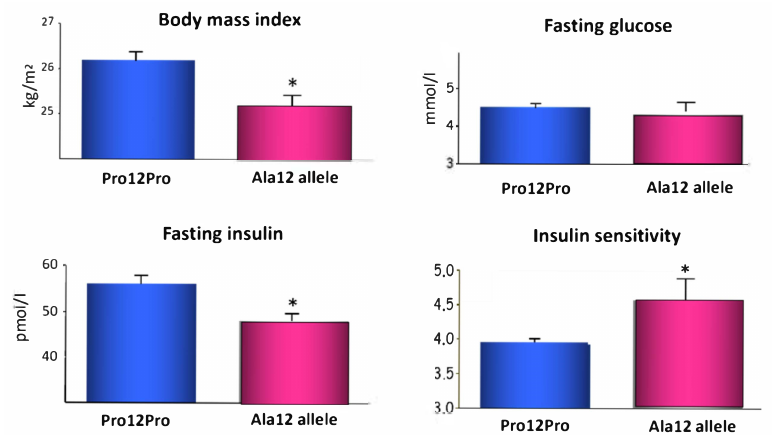
Figure 2. Body mass index and fasting insulin were significantly decreased and insulin sensitivity was increased (* p < 0.05) in the carriers of the Ala12 allele of PPARG2 . Altshuler et al. [19] performed a meta-analysis of 16 separate studies including over 3000 participants, and showed that the Pro allele of PPARG was significantly